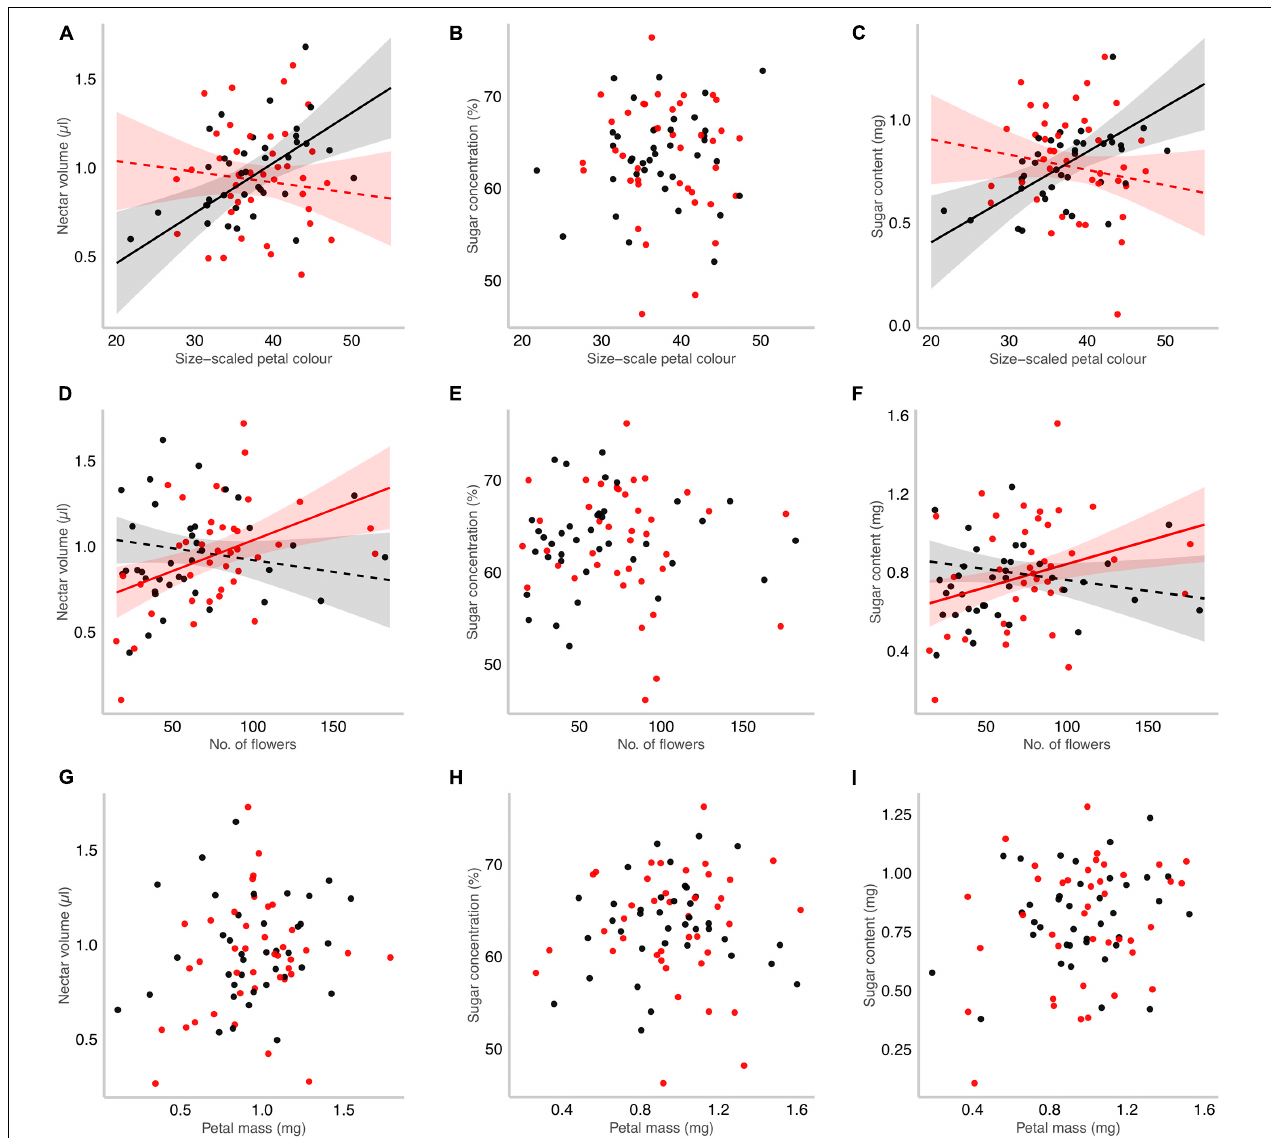
FIGURE 3 | Kinship effects on the floral signalling and reward relationship in Moricandia moricandioides . The floral signalling was characterised by three components: size-scaled petal colour measured as the red:green ratio index, and then multiplied by corolla size measured as corolla diameter (A–C) , flower number (D–F) , and petal mass (G–I) . Reward was quantified as nectar volume (A,D,G) , sugar concentration (B,E,H) , and nectar sugar content (C,F,I) . Slopes from LMM analyses and 95% confidence intervals are shown when the interaction between each floral signalling trait and neighbourhood relatedness were significant ( Table 2 ). Slopes significantly different from zero are also indicated with solid lines. Focal plants were grown with kin (red dots and line) or with non-kin neighbours (grey dots and